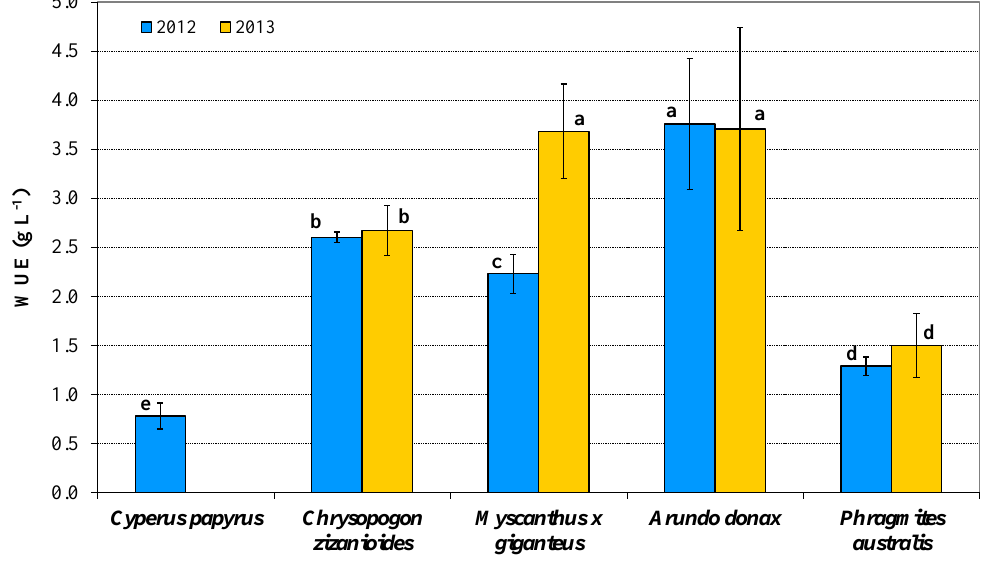
Figure 13. Water use efficiency (WUE) of the herbaceous species in December 2012 and 2013 (different letters indicate significant differences at p < 0.05).